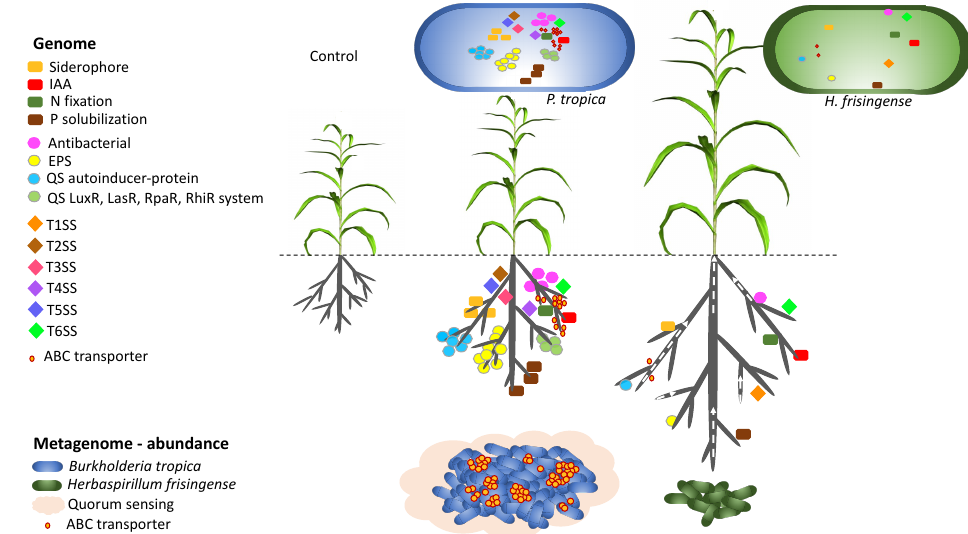
Figure 7. Concept framework of Paraburkholderia tropica strain IAC / BECa 135 and Herbaspirillum frisingense strain IAC / BECa 152 colonizing the rhizosphere of Sorghum bicolor cultivar SRN-39 based on comparative genomics and metagenomics. IAA: indol acetic acid; EPS: exoplolysaccharide; QS: quorum sensing; T1SS, T2SS, T3SS, T4SS, T5SS, and T6SS: types I, II, III, IV, V, and VI secretion systems, respectively.